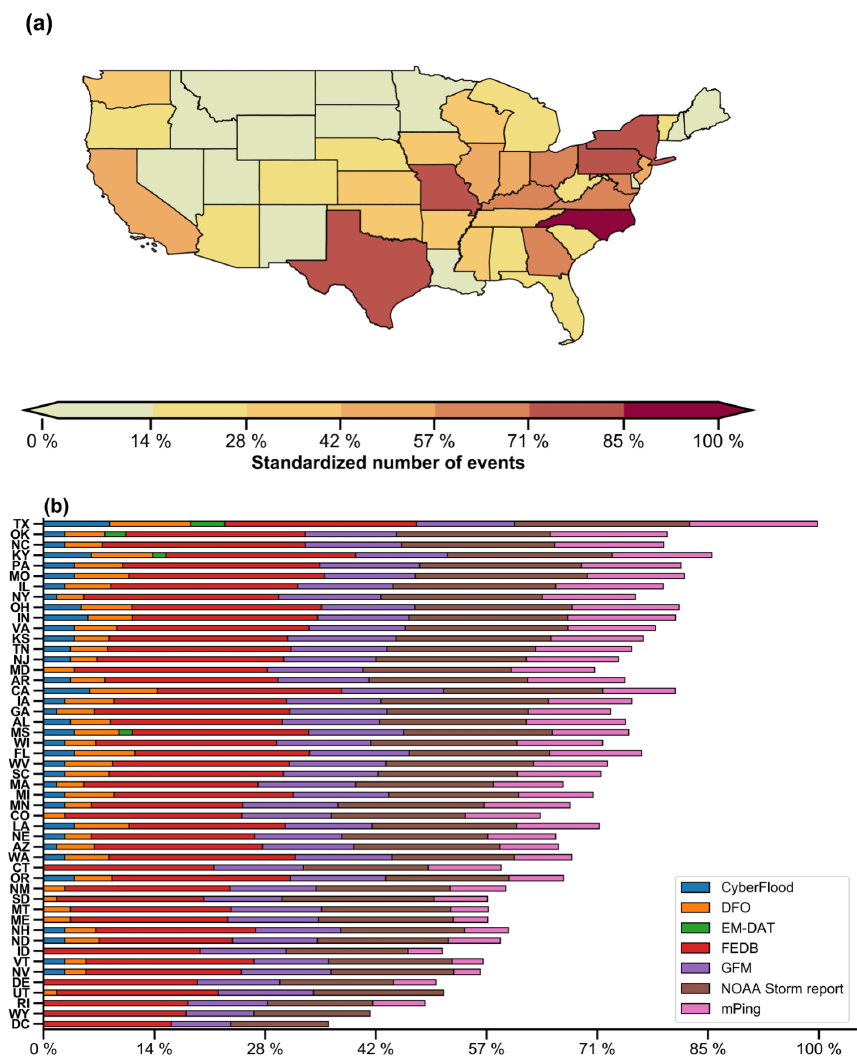
Figure 2. (a) Map of min–max standardized flood occurrences in the United States; (b) fractions of logarithmic event numbers of each candidate database to logarithmic total event